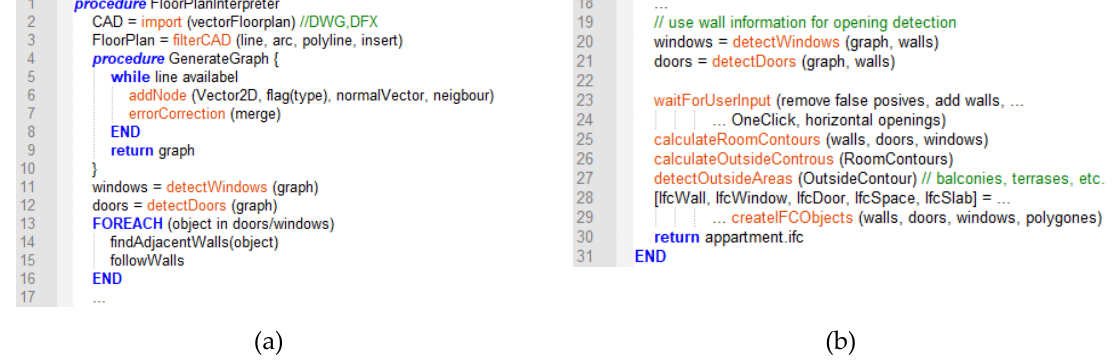
Figure 3. General procedure of the detection process of architectural components. ( a ) The first part of the procedure performs the generation of the graph and the detection of openings and adjacent walls; ( b ) In the second phase the user can verify and adjust the result before rooms and outside areas are detected. Finally the IFC objects are exported.